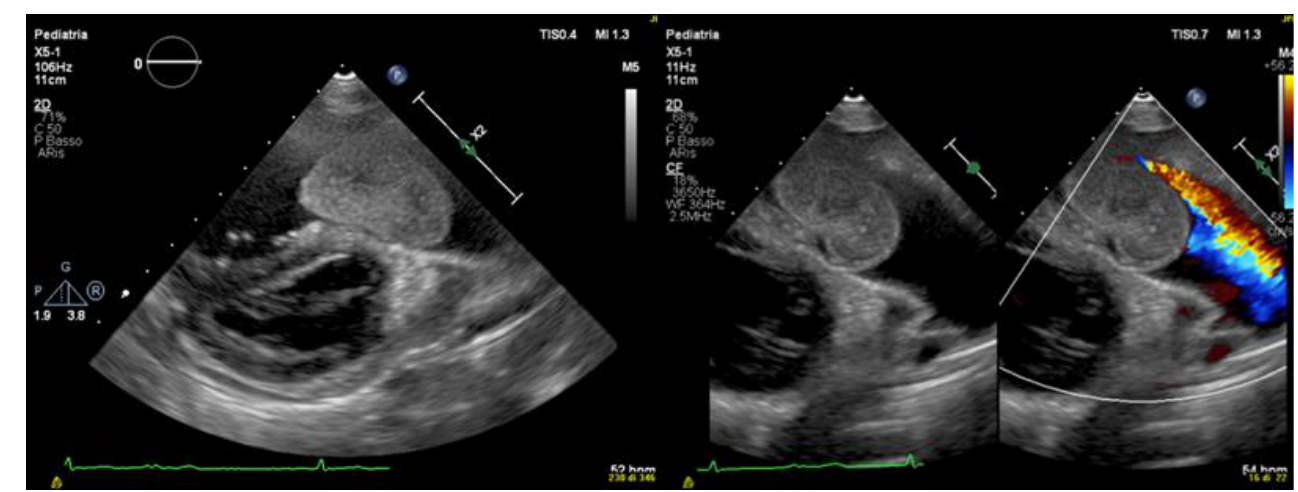
Figure 2. Color Doppler transthoracic echocardiography. Transthoracic echocardiography shows the presence of a mobile intracardiac mass protruding into the right outflow, attached to the infundibular septum by a peduncle.